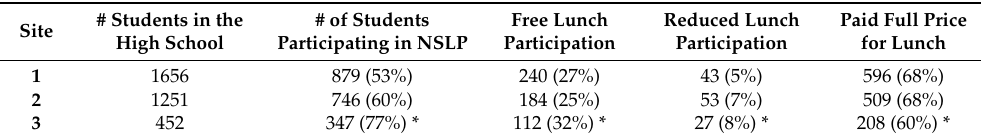
Table 3. School-level demographics of the three participating